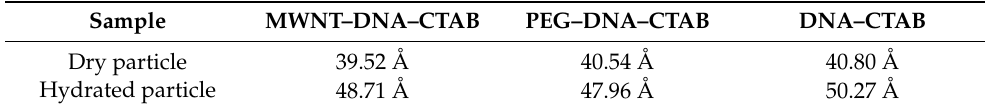
Table 2. Repeating distances of the dry and rehydrated gel particles at 25 ◦ C.